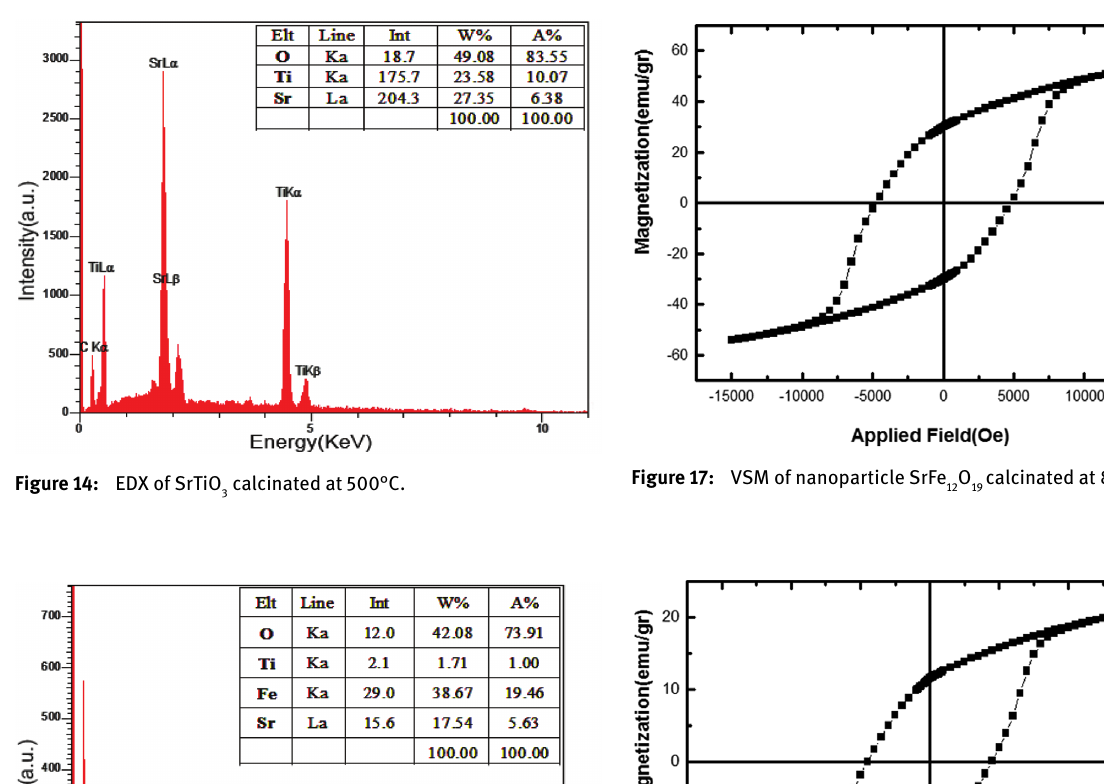
O calcinated at 850°C. 12 19